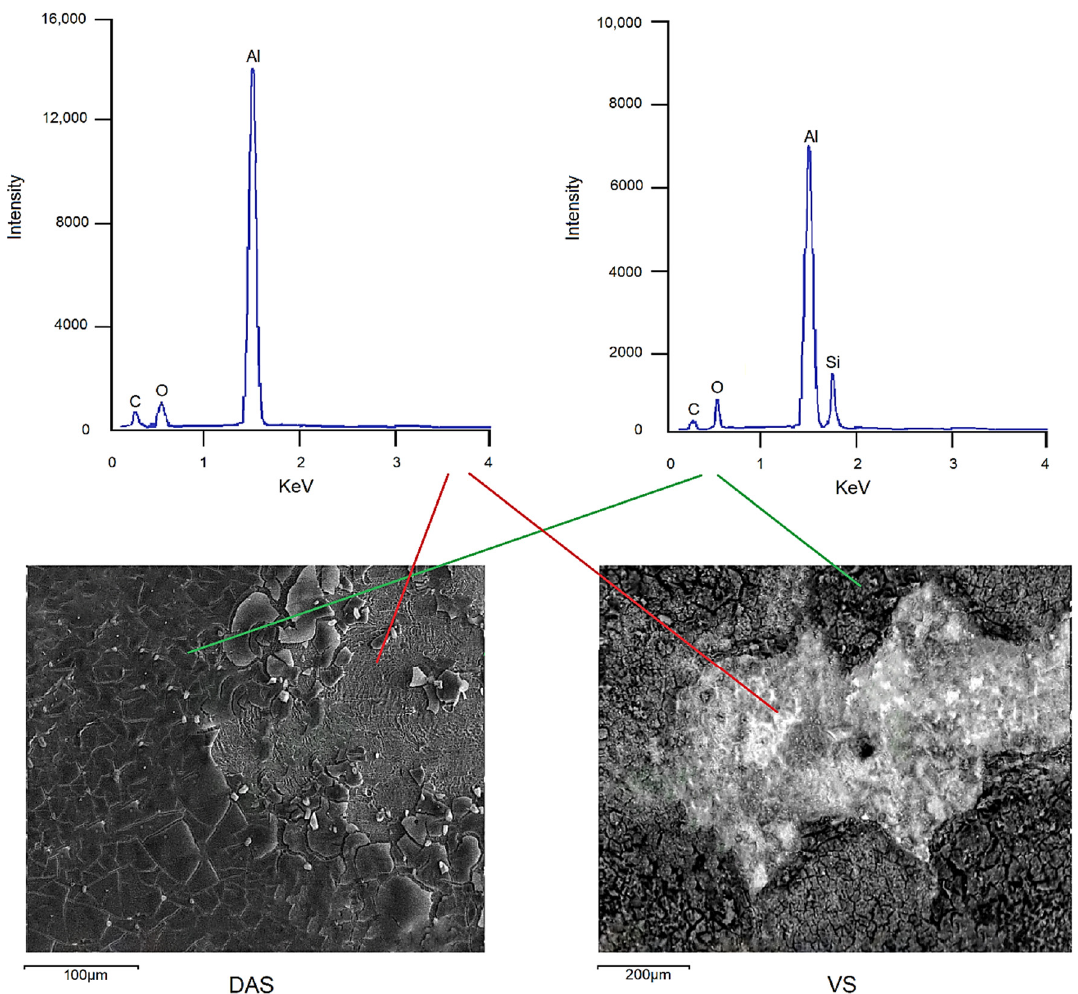
Figure 8. Microphotography of diaminsilane and vinyltrimethoxysilane films and EDS spectra on the surface of Al after 720 h of exposure in the climatic chamber at a temperature of 60 °C and humidity of 98%.